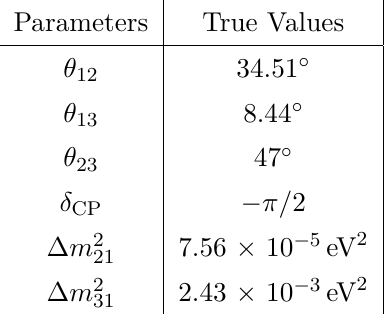
Table 1 . The benchmark values of oscillation parameters used